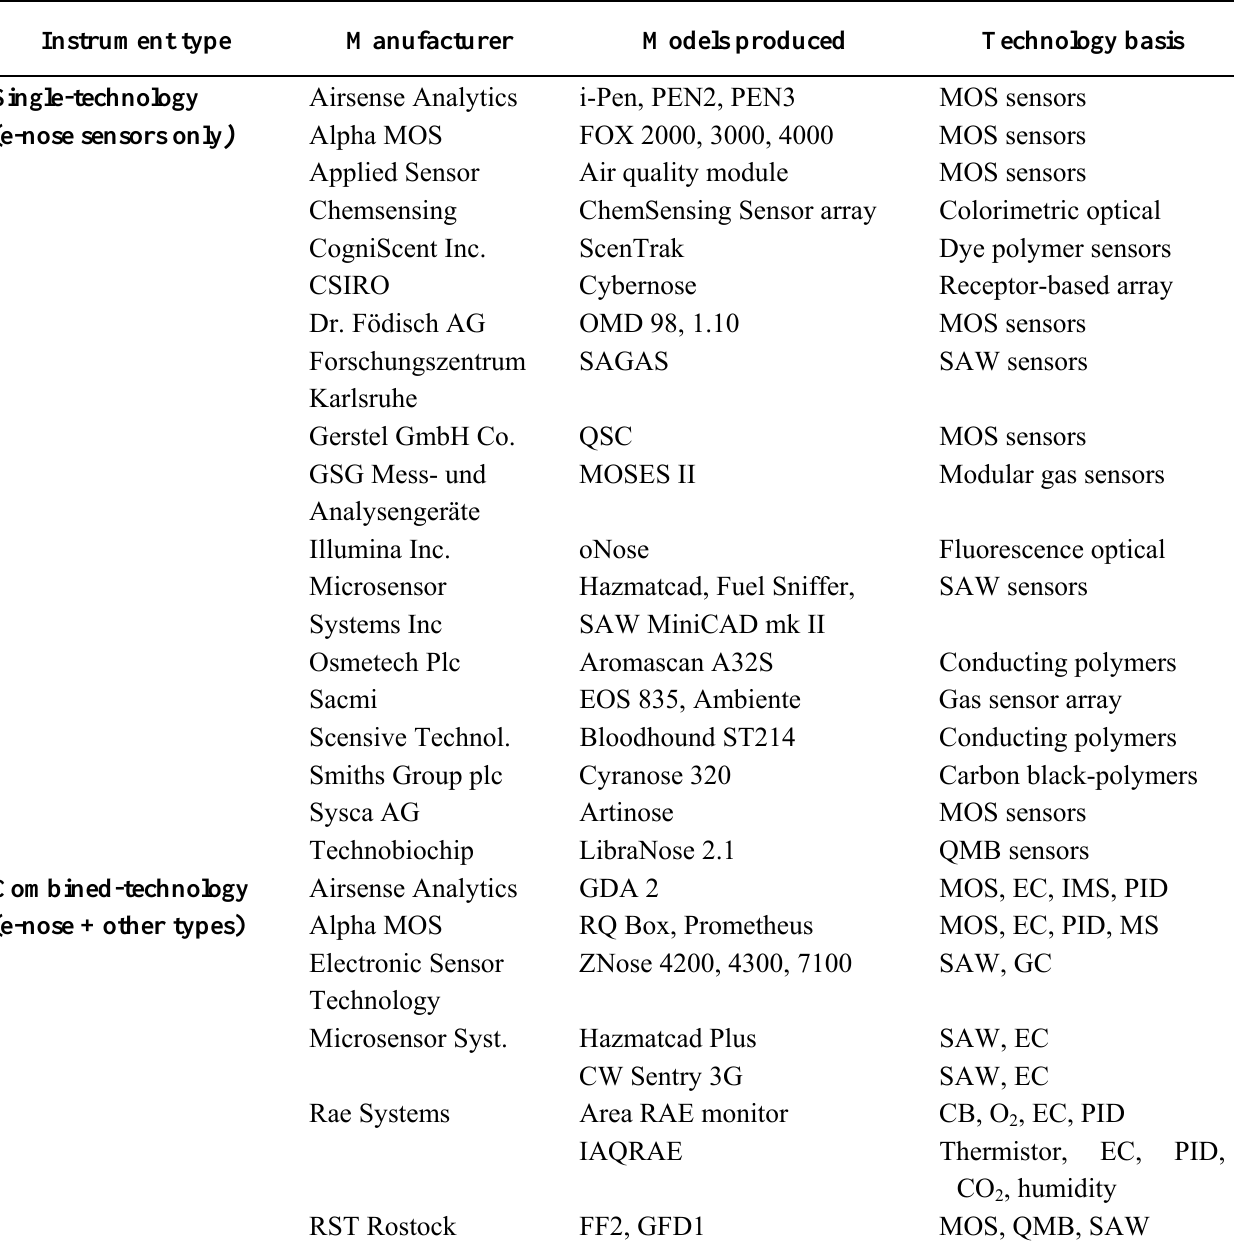
Table 6. Some commercially available electronic noses, models and